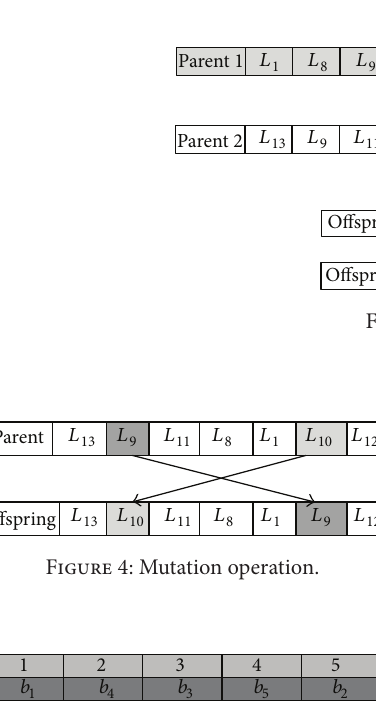
Figure 5: Chromosome